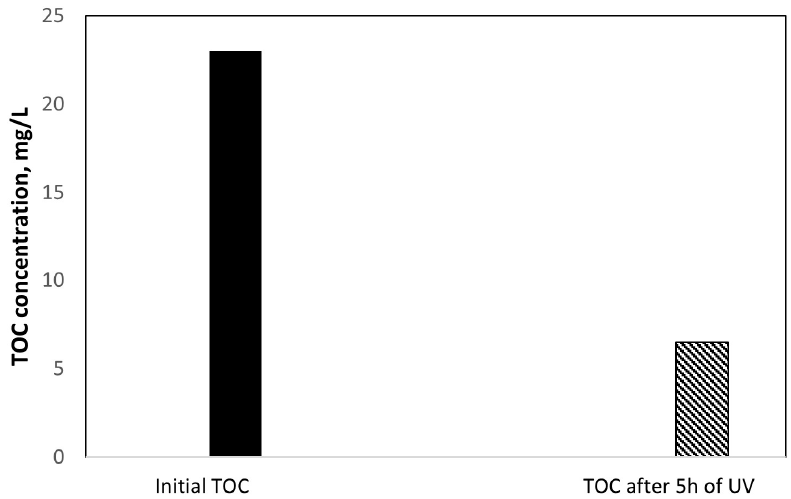
Figure 12. TOC before and after the photodegradation of CIP.